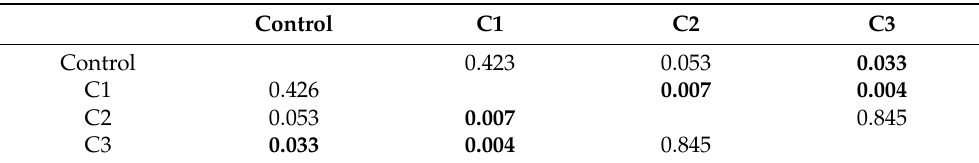
Table 1. Dunn’s post hoc for condition index (Bonferroni corrected p values). Significant differences shown in bold.